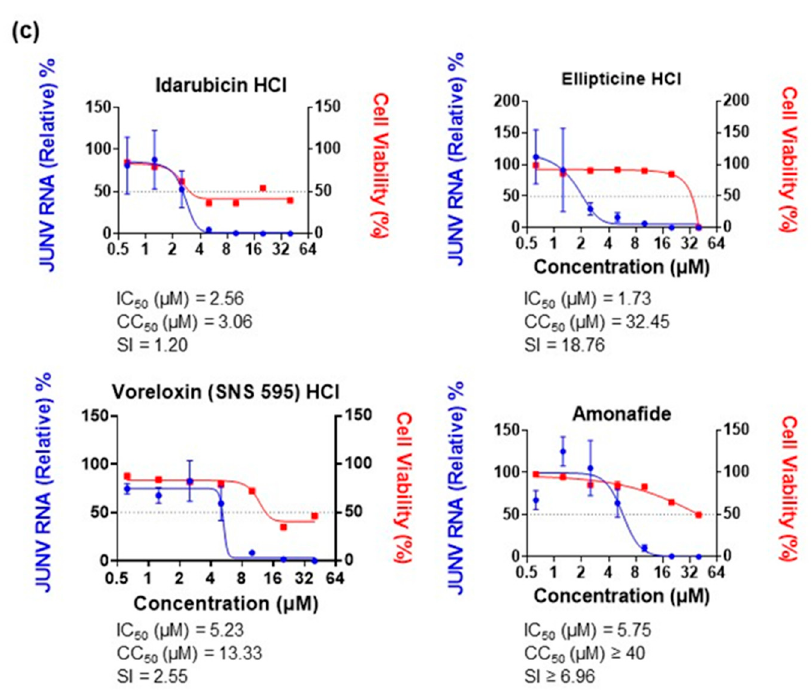
Figure 5. Inhibition of replication of JUNV by identified candidates and topoisomerase II inhibitors. ( a ) Restriction of JUNV replication by positive controls, MPA and ribavirin. A549 cells were seeded